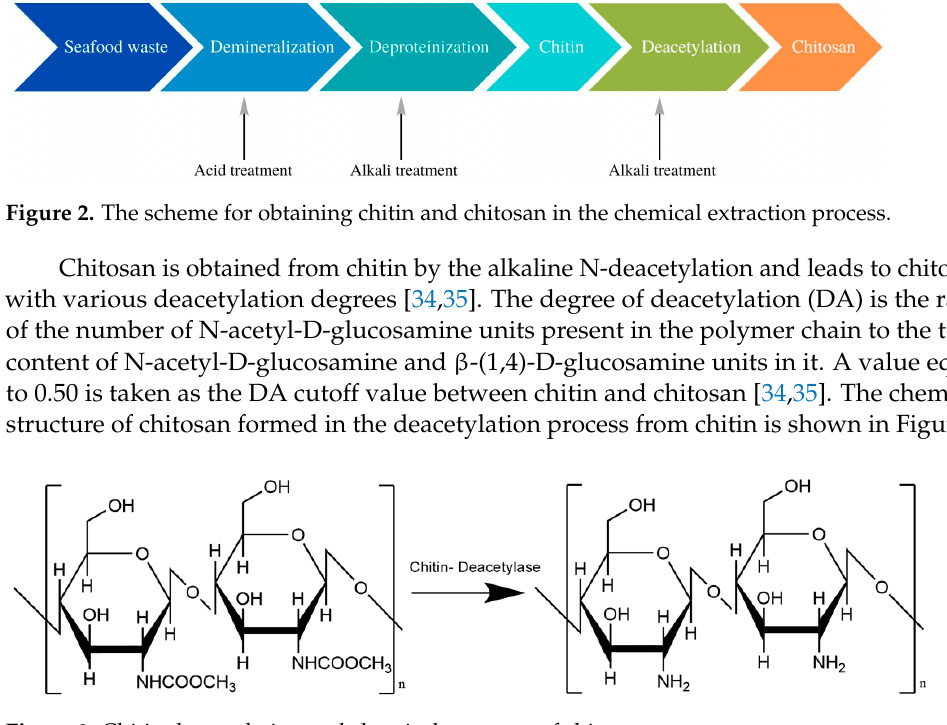
Figure 3. Chitin deacetylation and chemical structure of chitosan.